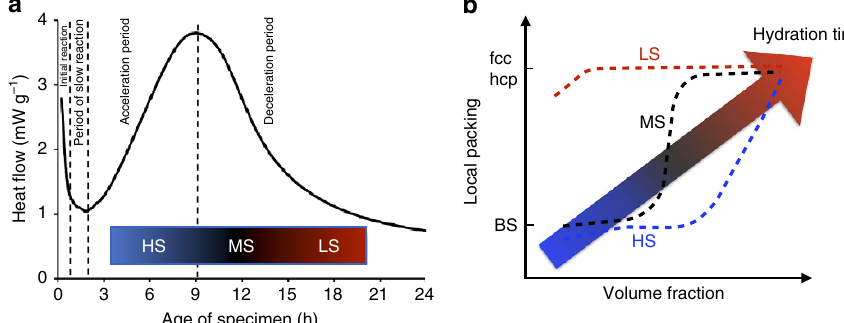
Figure 6 | Hydration kinetics and nanoscale interactions. ( a ) The hydration rate as measured via calorimetry during cement hydration reprinted from ref. 6 (with permission from Elsevier, published subscribed access). It displays the acceleration, deceleration and further densification regime of the kinetics. The colour bar indicates the corresponding evolution of the effective interactions from HS to LS. ( b ) Schematic drawing of pathways to mechanical strength. To achieve optimal mechanical strength, cement hydrates should first form an open percolating network that can act as a scaffold to form homogeneous dense structures (see text). The figure shows the aggregation pathways (dashed lines) observed in our simulations of HS (blue), MS (black) and LS (red), whereas the arrow indicates a possible pathway during cement hydration. The axis of local packings measures the transition from fibrillar (for example, BS) to compact (fcc/hcp) structures while the system densifies (increasing the volume fraction f ). As can be seen from the figure, repulsive interactions (HS or MS) are essential for forming the open, fibrillar scaffold. Subsequently, these structures form more compact (fcc or hcp) structures. The transition to a mainly attractive (LS) potential favours hcp. However, the LS potential alone cannot form the low-density fibrillar network and would therefore lead to the formation of heterogeneous high-density